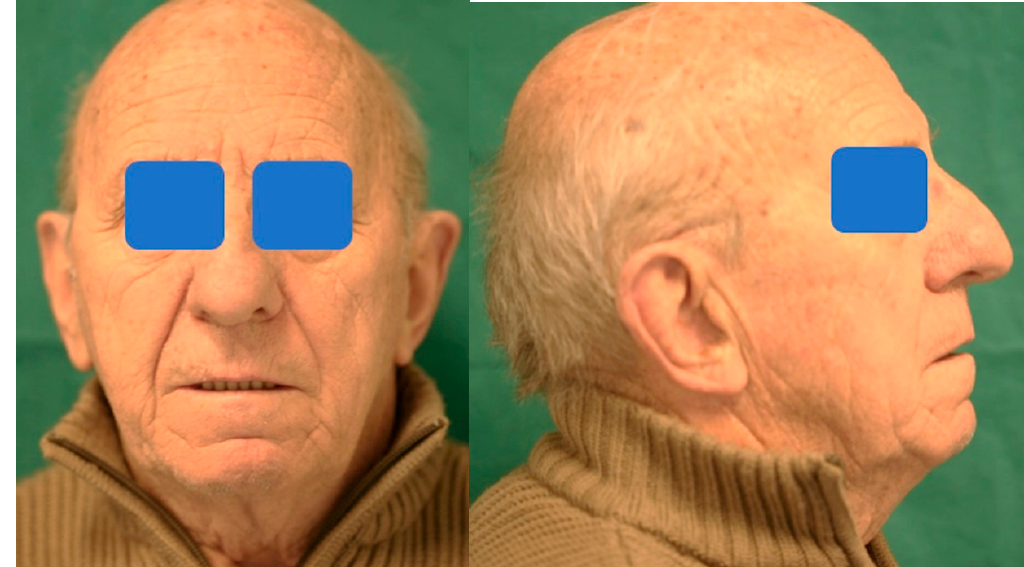
Figure 1. Pre-operative frontal and lateral view of the patient.